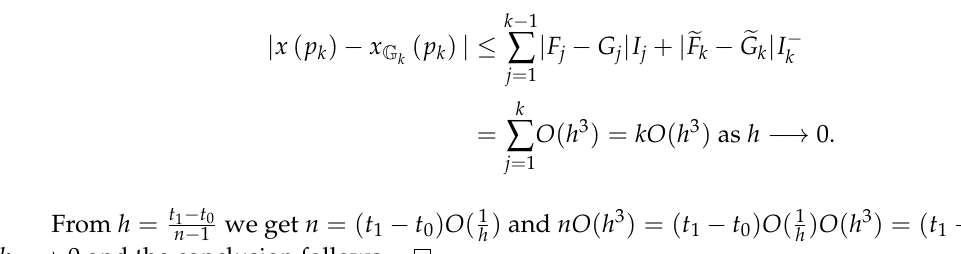
· ( t ) of the ODE x ( t ) = f ( t , x ( t )) , 1 , A )